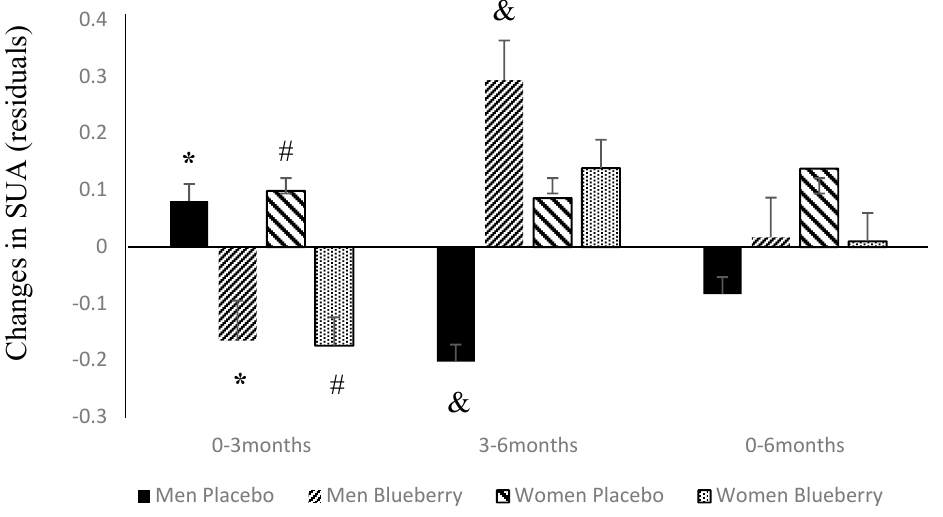
Figure 2. SUA (serum uric acid) changes over 6 months according to sex and treatment group. Residual values are shown as mean (SD); * p = 0.0002, # p = 0.00001, & p = 0.0006